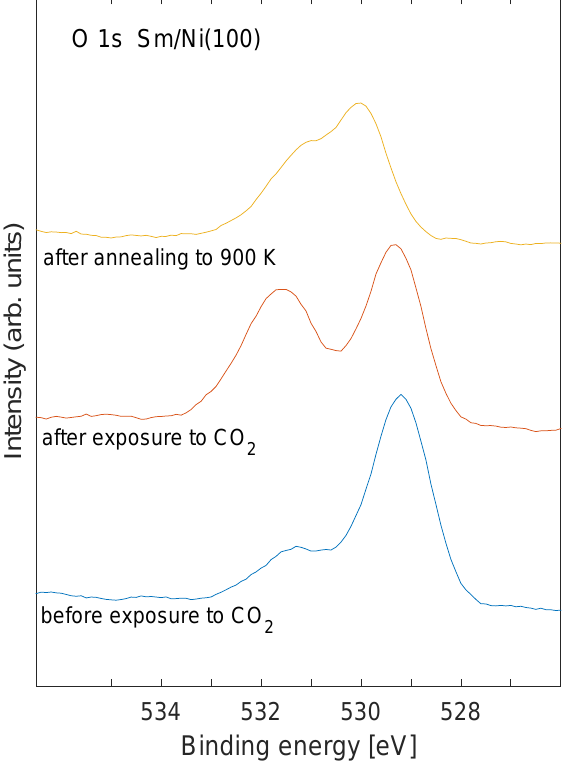
Figure 2. O 1s XPS recorded before exposure to CO 2 ( bottom spectrum ), after exposure to CO 2 ( middle spectrum ), and after annealing to 900 K ( top spectrum ). The Sm coverage was estimated to 0.8